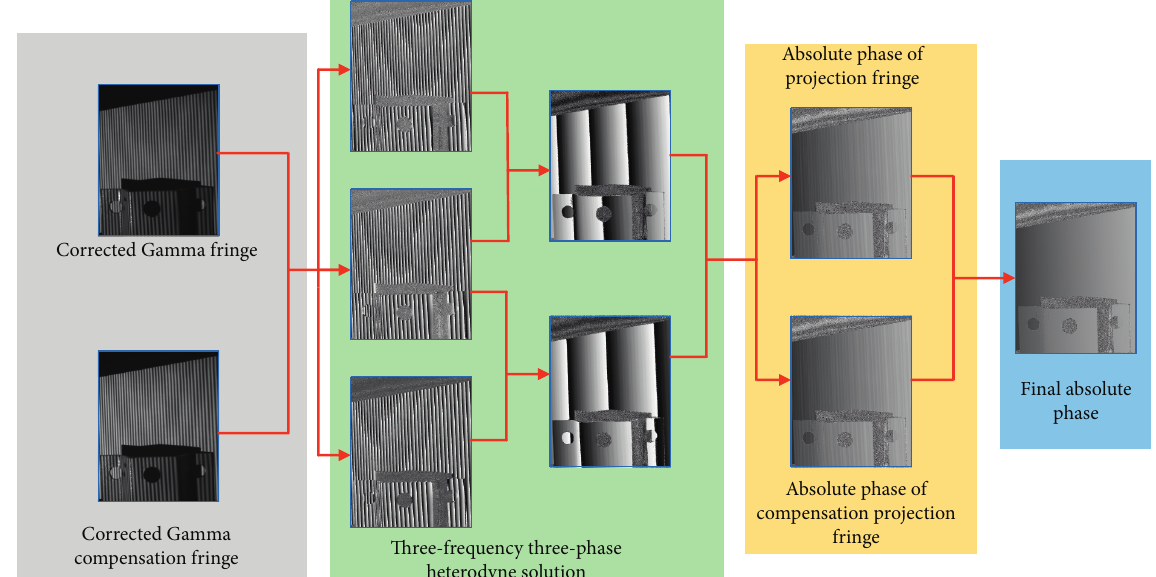
Figure 9: Schematic diagram of phase error compensation